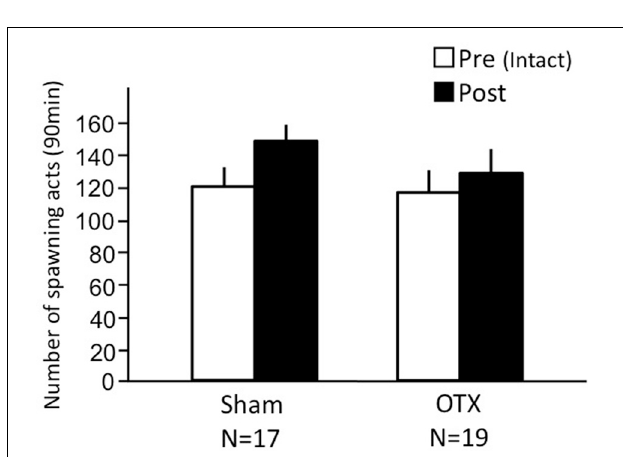
FIGURE 4 | Effects of olfactory tract section on female sexual behavior in female goldfish. Pre, Pre-treatment (open column). Post, post-treatment (solid column). Each column represents the mean and s.e.m.